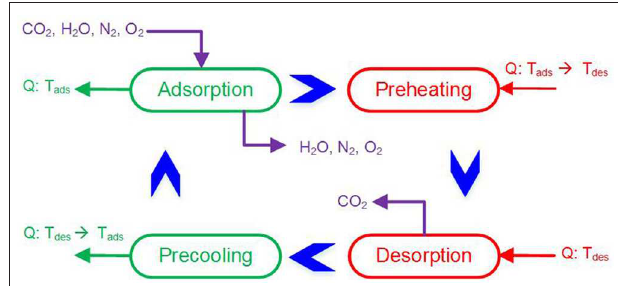
FIGURE 2 | Simple schematic of TSA cycle with four steps. Q, Heat Supplied or Removed; T ads , Absorption Temperature; T des , Desorption